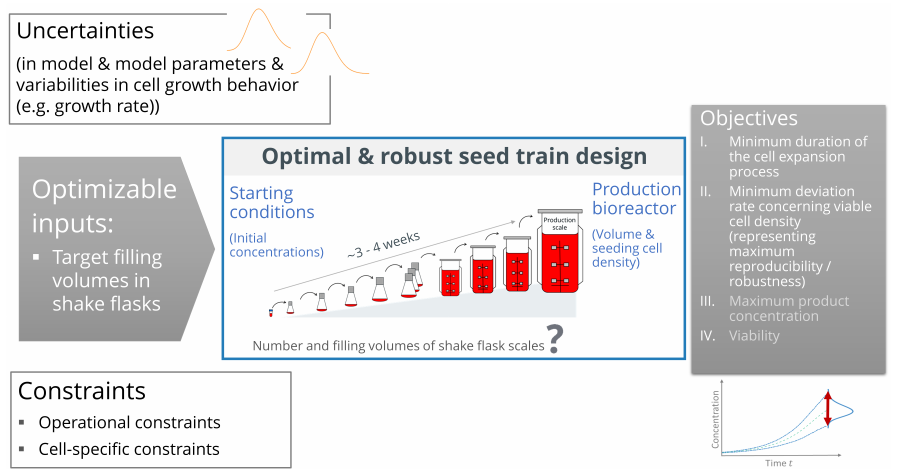
Figure 1. Goal of the study is to propose a concept and a numerical framework for optimal robust seed train design (blue box in the middle), including optimizable inputs (first gray box) as well as objectives (objective criteria) used in this study (right gray